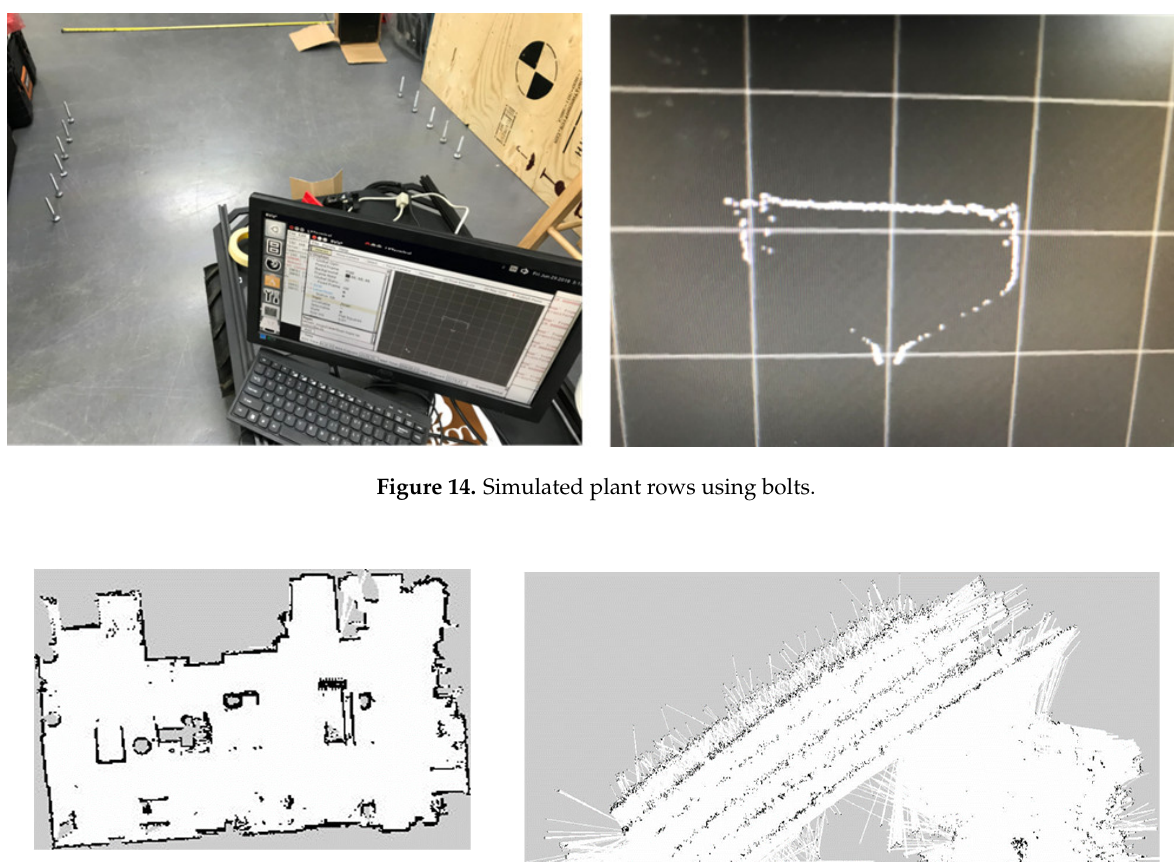
Figure 13. Results of GPS accuracy measurements.